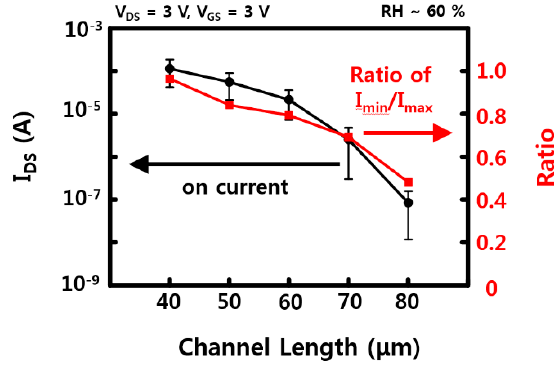
Figure A7. On current and the ratio of on currents between the devices which show the lowest on